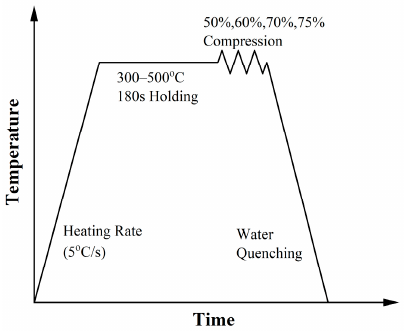
Figure 1. Experimental procedures for the hot compression.